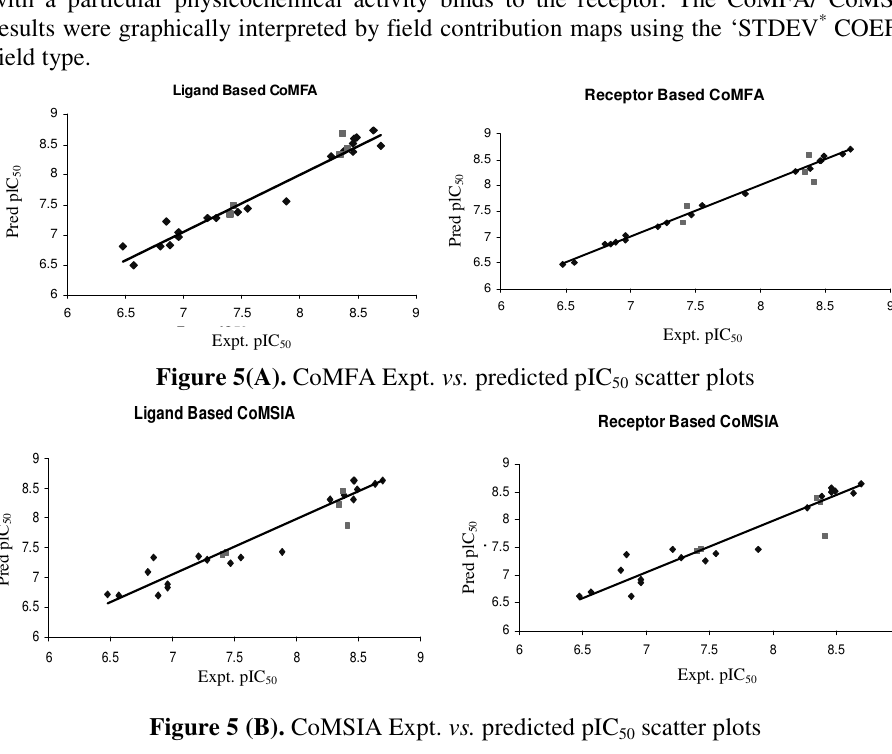
Figure 5 (B). CoMSIA Expt. vs. predicted pIC